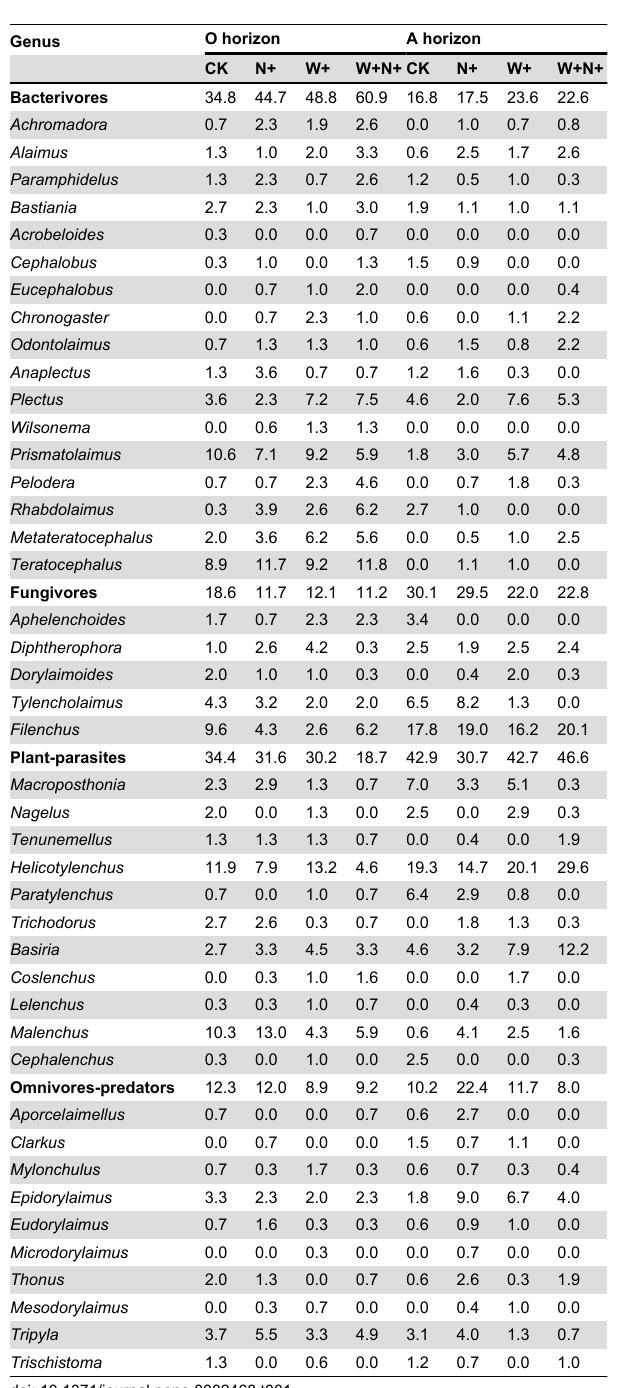
Table 1. The relative abundance (%) of nematode genera among different treatments.